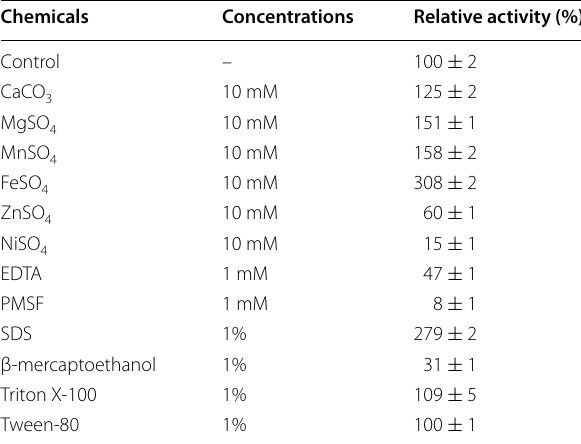
Table 3 Effect of chemicals on KerP activity Chemicals